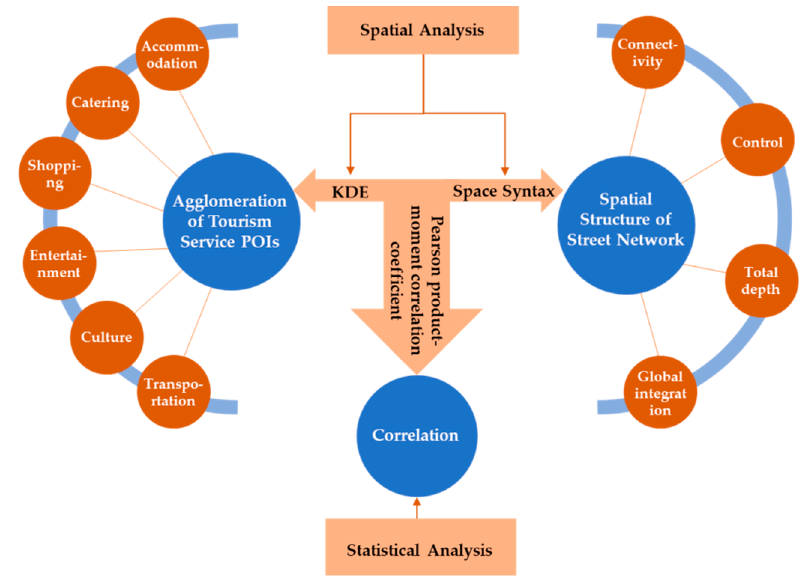
Figure 2. Methods used in this study